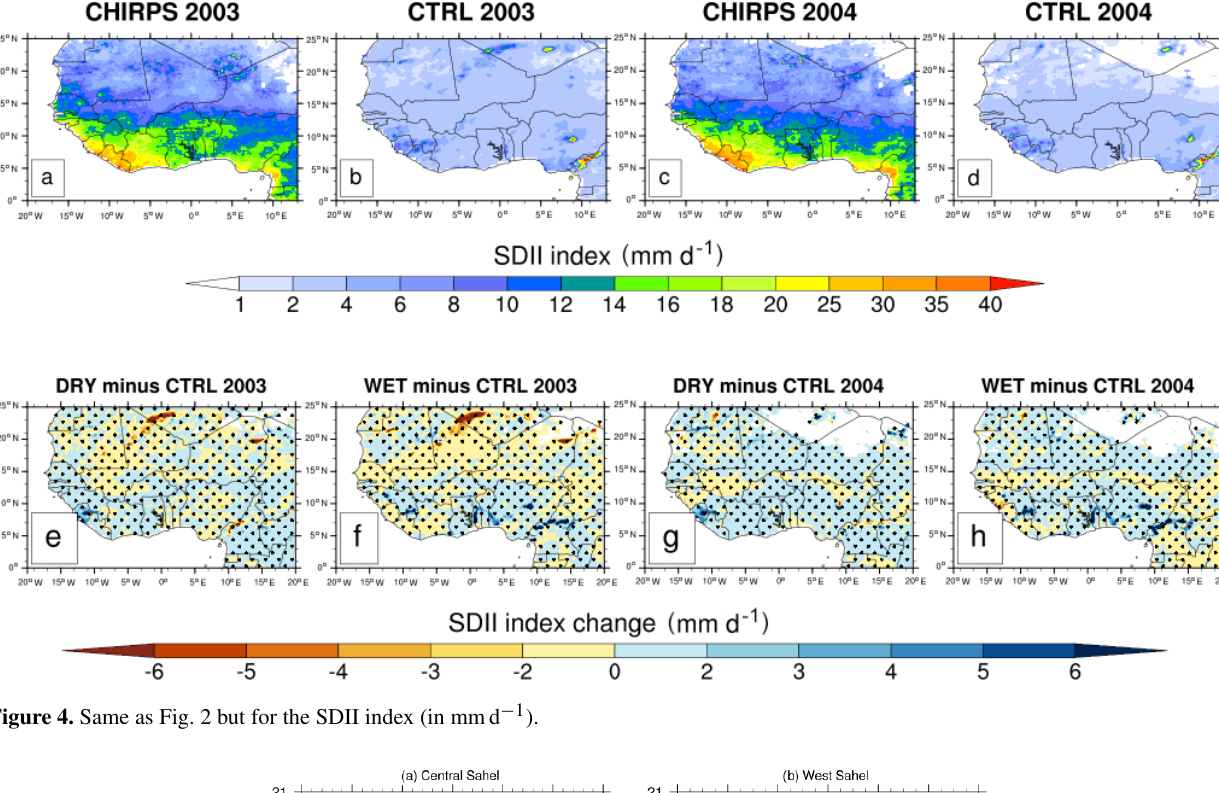
Figure 4. Same as Fig. 2 but for the SDII index (in mmd − 1 ).